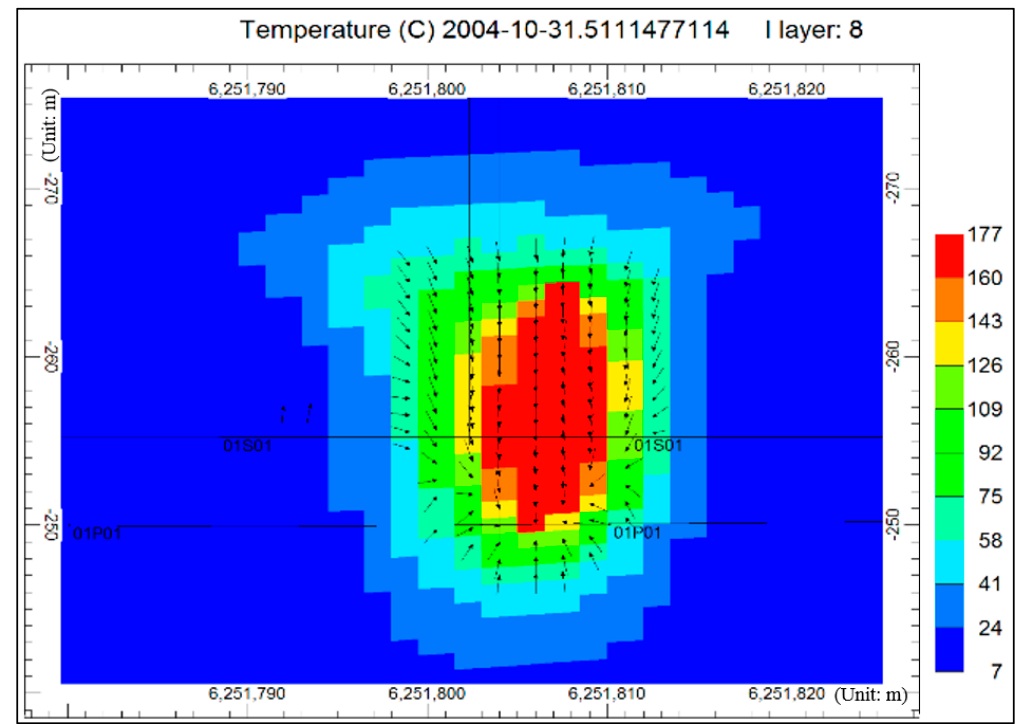
Figure 17. Steam chamber during the production with oil flow vector.